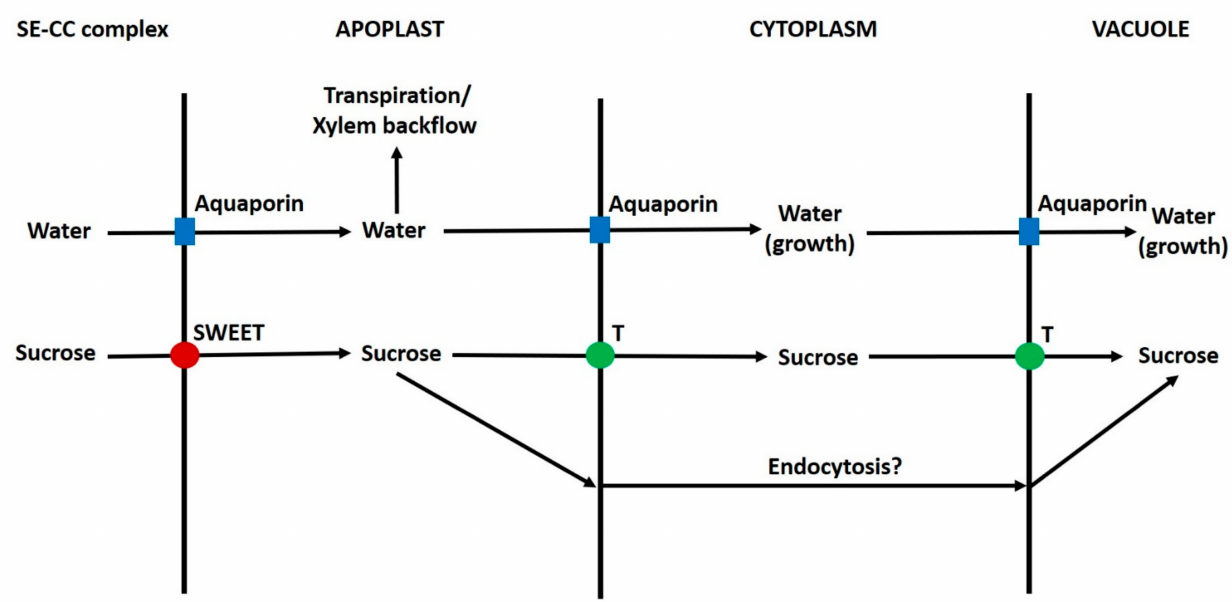
Figure 5. Sucrose transport and associated metabolism in sucrose-accumulating tomatoes. Sucrose exits the SE-CC complex via a SWEET, and then it moves through the apoplast largely by bulk flow, which can be largely generated by transpiration or, potentially, by xylem backflow. Sucrose can enter the parenchyma cells of the flesh and into the vacuole via transporters or, possibly, by endocytosis. Uncertainty about the occurrence of endocytosis is indicated in the figure by the question mark. Aquaporin water channels enable a rapid osmotically driven bulk flow of water. Abbreviations: SE-CC = sieve element-companion cell; SWEET = sucrose will eventually be exported transporter; T = sugar